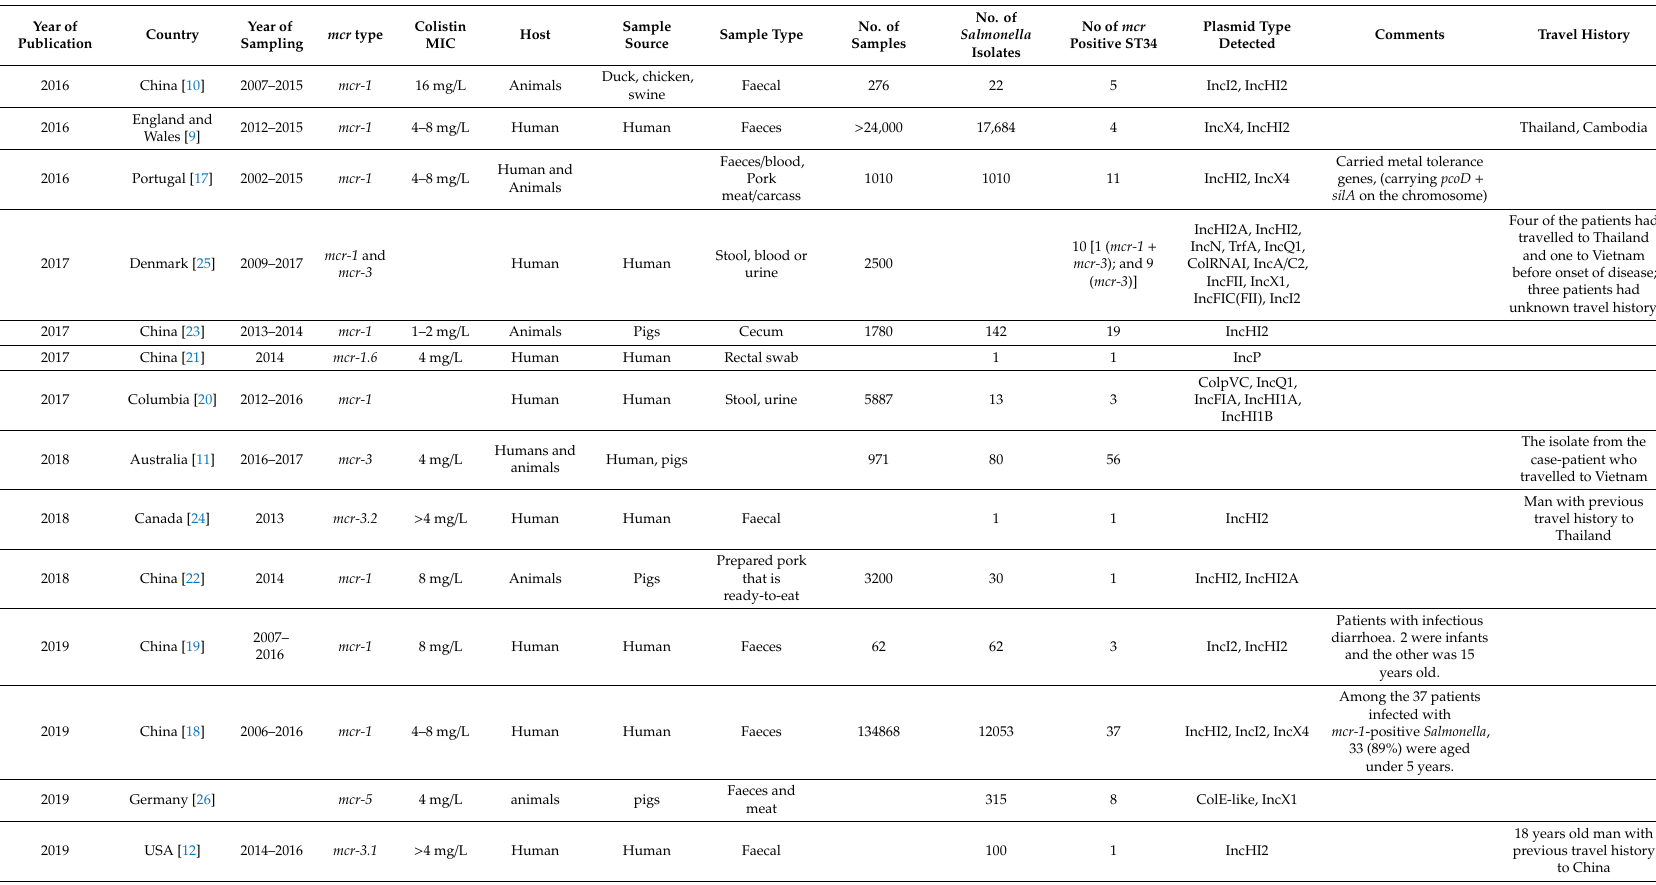
Table 2. Characteristics of the mcr- positive Salmonella Typhimurium monophasic clone ST34 found in di ff erent studies